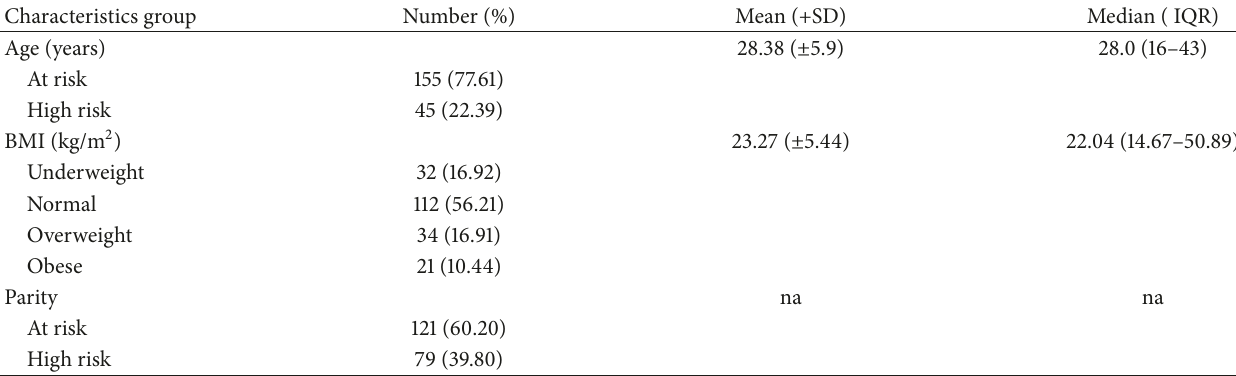
Table 1: Descriptive summary of study subjects’ characteristic.